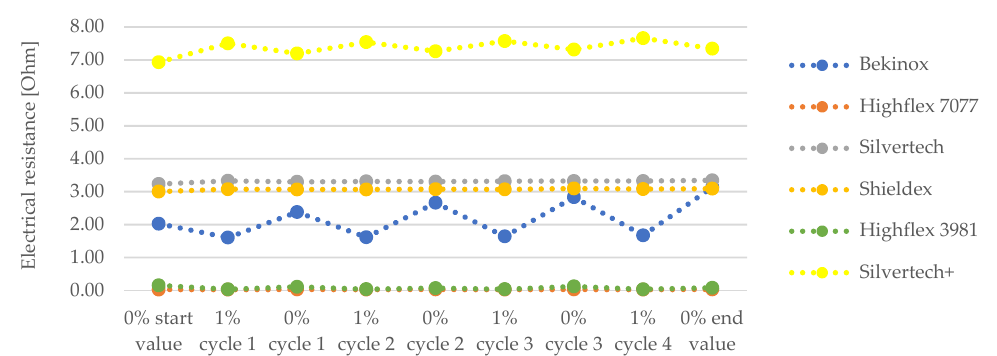
Figure 9. Change of electrical resistance of uncoated substrates upon loading and unloading showing too few changes during load cycles.